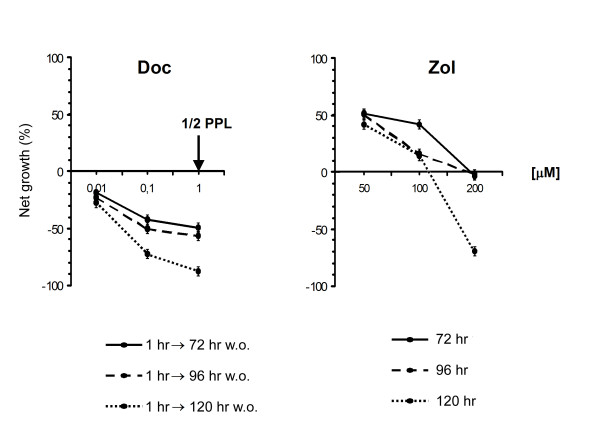
Dose effect curves of Doc and Zol in LNCaP hormone-sensitive cell line. Net cell growth was measured by SRB assay at the end of different washout (w.o.) times after a 1-h exposure to scalar concentrations of Doc (0.01, 0.1, 1.0 μM – left diagram) and after continuous exposure to scalar concentrations of Zol (50, 100, 200 μM – right diagram). Error bars represent the mean standard deviation.